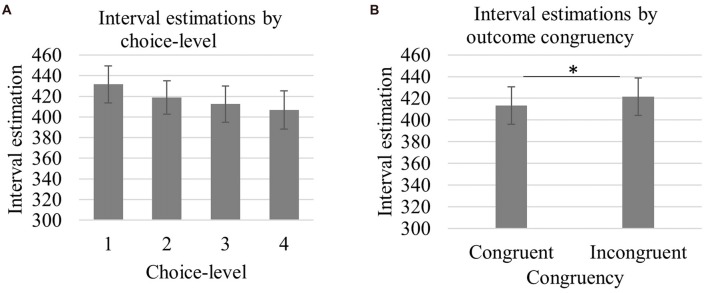
Mean interval estimations as a function of choice-level (A) and outcome congruency (B). Interval estimations were significantly reduced with increasing choice-level (p < 0.001) and were greater for incongruent compared to congruent outcomes (*p = 0.047). The interval estimates were averaged across all three intervals (100 ms, 300 ms, 500 ms). Error bars represent standard error of the mean.